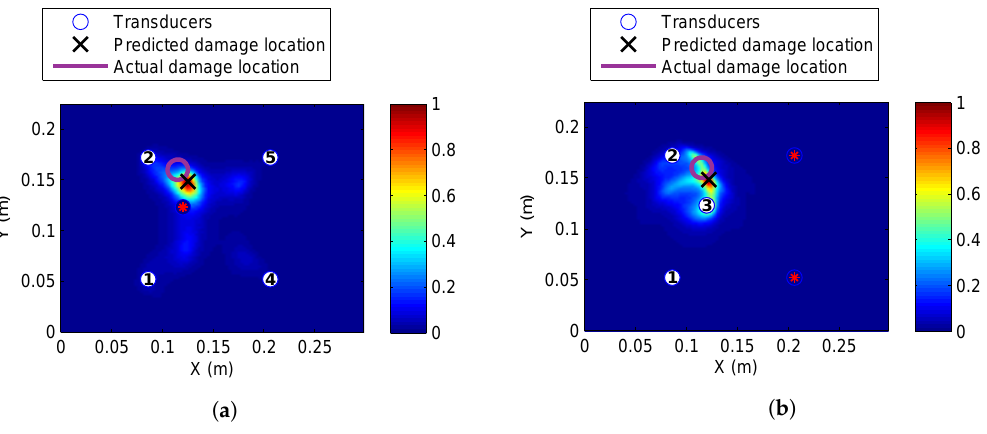
Figure 15. Damage localisation for BVID on the CFRP panel at ( a ) 300 kHz and ( b ) 50 kHz. Damage current and baseline signal recorded under vibration. For ( b ), 50 kHz only using transducer paths that do not cross a fixture clamp. ( a ) Three hundred kilohertz, four transducers; ( b ) 50 kHz, three